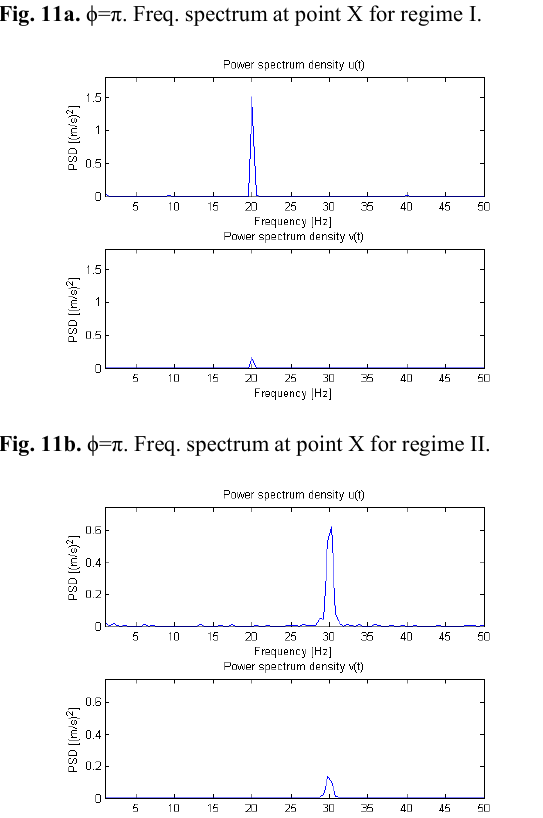
Fig. 11a. ϕ=π . Freq. spectrum at point X for regime I.